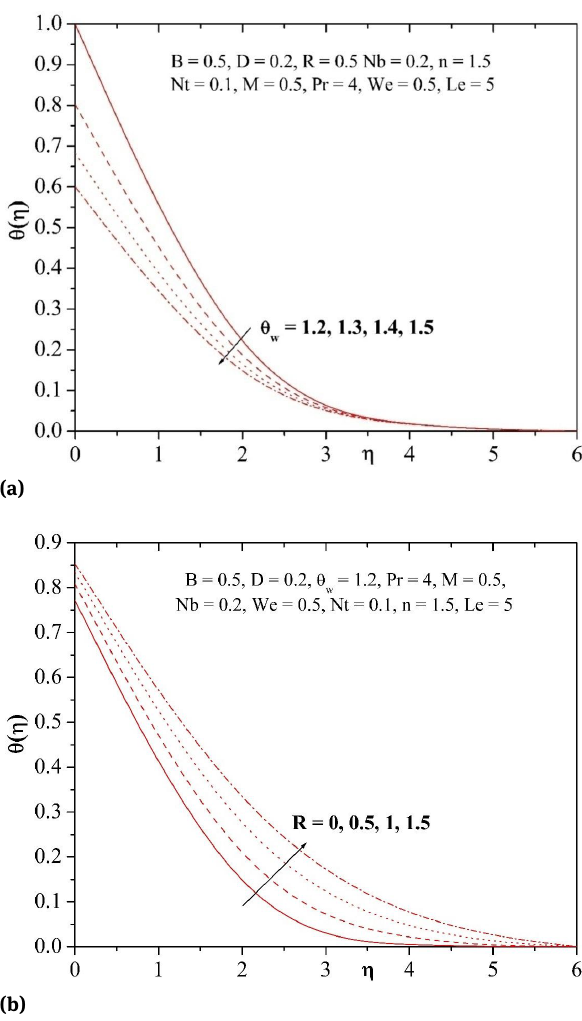
Fig. 8: (a) Influence of θ w on temperature profile. (b) Influence of R on temperature profile.